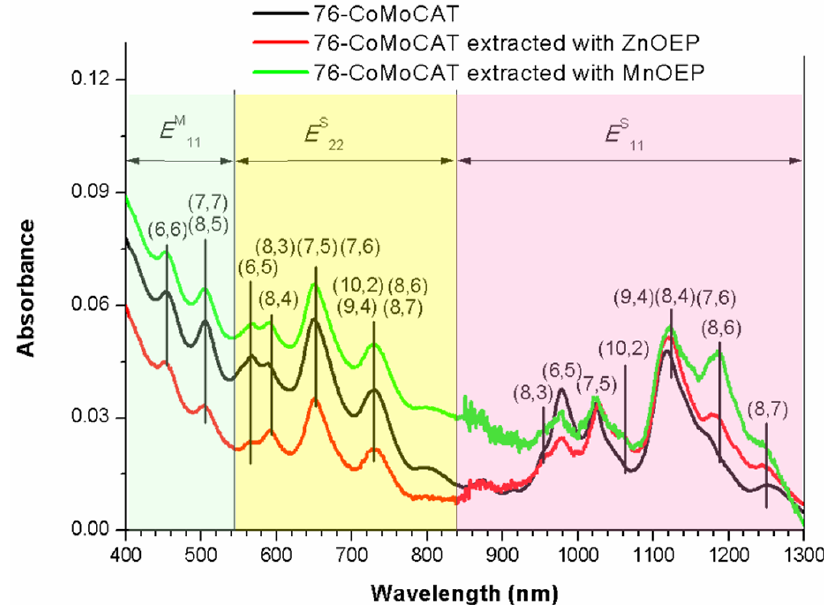
Figure 5. UV-Vis–NIR spectra of D extracted with ZnOEP and